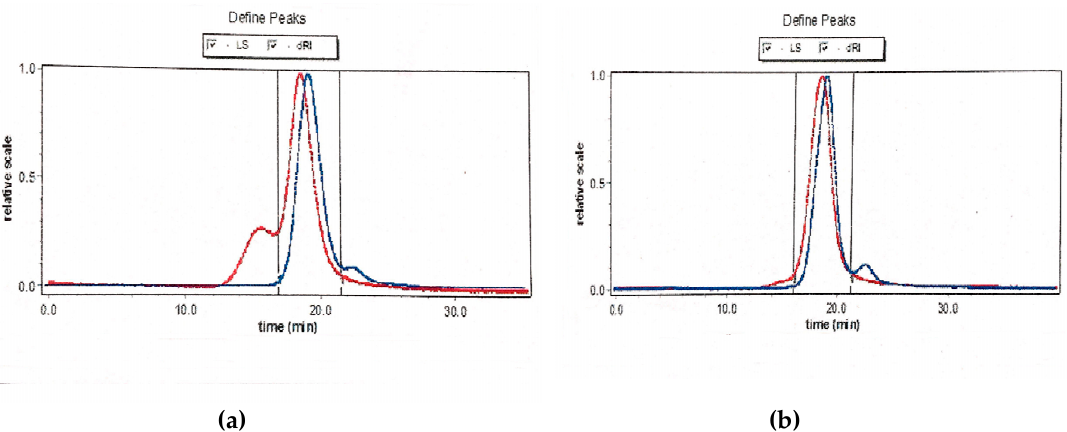
Figure 3. performance size-exclusion chromatography (HPSEC) elution pro fi les of PCp-I ( a ) and PCp- II ( b ). Table 2. Molecular weight of PCp-1 and PCp-4.